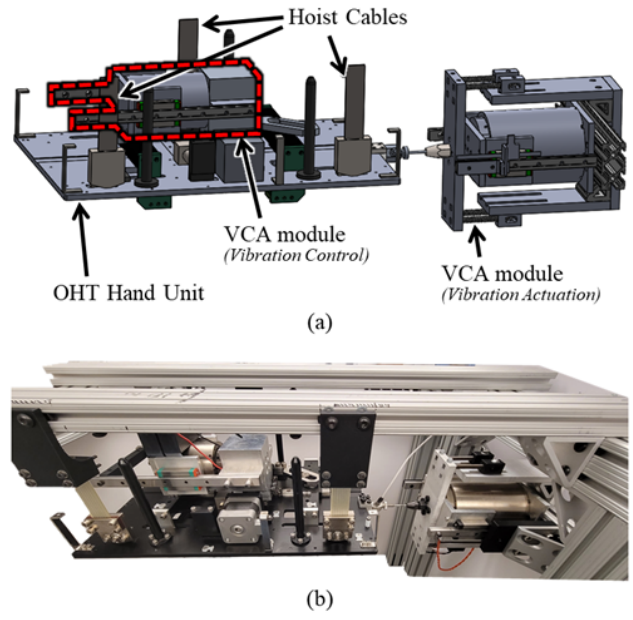
Figure 2. ( a ) CAD of the vibration testbed and ( b ) photograph of the fabricated